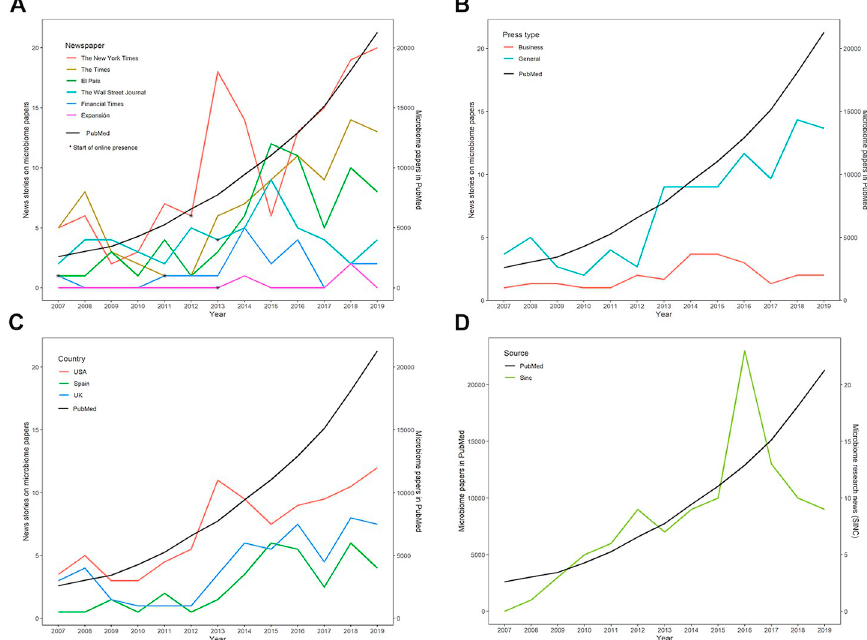
Fig 2. News stories on microbiome papers compared to microbiome papers in PubMed. (A) Individual newspapers; (B) General vs business newspapers; (C) Newspapers grouped by countries (the USA, the UK and Spain); (D) Microbiome news/biomedicine news published by SINC (2008–2018) vs microbiome papers/biomedicine papers in PubMed (2007–2019). Microbiome papers in PubMed are presented as a black curve on each graph.